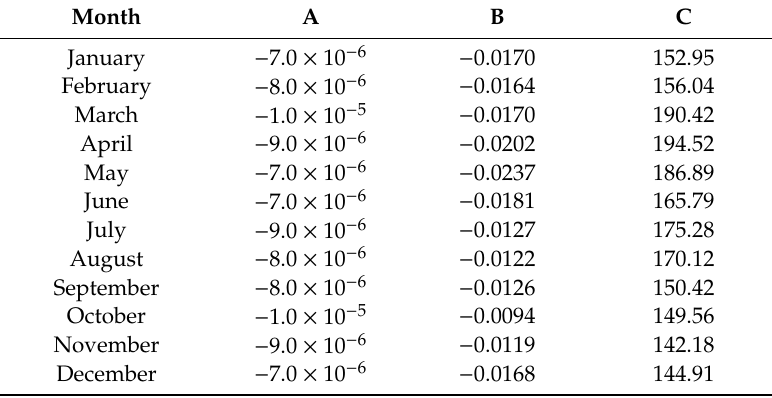
Table 3. Potential evapotranspiration–elevation equation parameters (A, B and C). Reproduced from Integrated and Dynamic Water Balance in El-Salvador. National Service for Territorial Studies of El-Salvador (2005) [13].